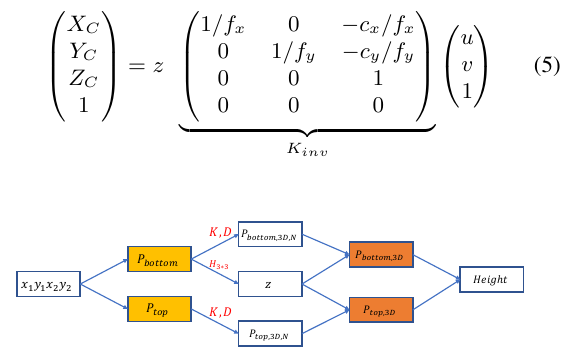
Figure 6. HE-Net flowchart. x 1 y 1 x 2 y 2 is bounding box location in image. P bottom and P top represent object bottom and top pixel location. Respectively, P bottom, 3 D,N and P top, 3 D,N are depth-normalized 3D points in camera coordinate frame. z is object estimated depth. P bottom, 3 D and P top, 3 D are estimated inverse-projected points in camera frame.